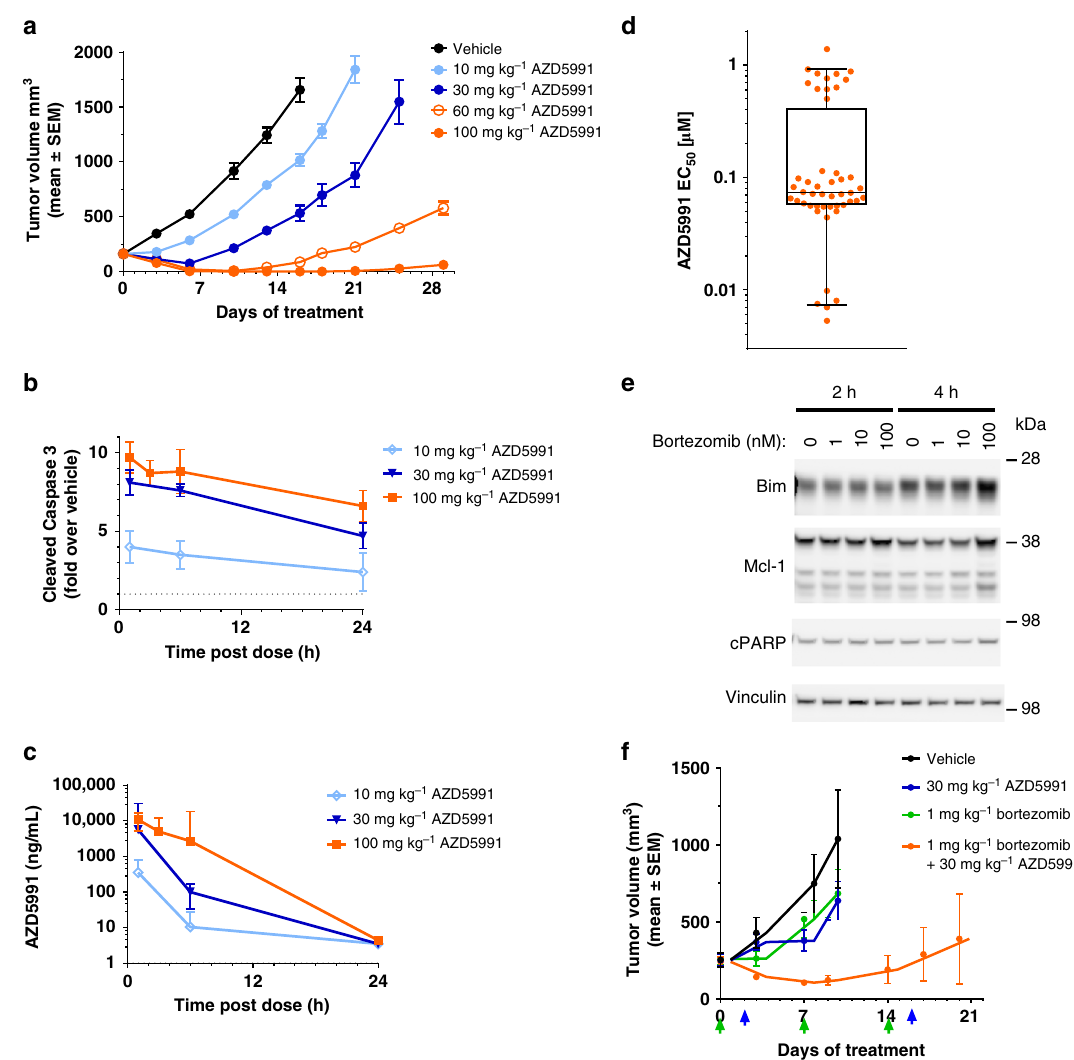
Fig. 6 AZD5991 exhibits potent anti-tumor ef fi cacy in MM models. a Subcutaneous tumor growth in the MOLP-8 tumor model treated with a single i.v. dose of AZD5991 10 – 100 mg kg − 1 . Tumor volumes are presented as mean ± SEM, seven mice were evaluated per group. b MOLP-8 tumor lysates prepared from mice dosed with a single i.v. dose of AZD5991 at 10, 30, or 100 mg kg − 1 were evaluated for expression of cleaved caspase-3 by MesoScale discovery assay. Mean± SD are shown. c In vivo plasma concentration of AZD5991 following a single i.v. dose of AZD5991 10 – 100 mg kg − 1 to mice with subcutaneous MOLP-8 tumors. AZD5991 plasma concentrations were assessed through the fi rst 24 h following compound administration. Concentrations of AZD5991 (ng mL -1 ) are plotted on a log 10 scale as mean ± SD ( n = 3). d Apoptosis in mononuclear cells isolated from bone marrow aspirate of MM patients ( n = 48) treated with increasing concentrations of AZD5991 for 24h and evaluated by Annexin V by fl ow. Each dot represents a unique patient sample. center line indicates the median, bounds of box denote 25% (lower) and 75% (upper) percentile, and whiskers encompass 5 – 95 percentile. e NCI- H929 cells were treated with bortezomib at the indicated concentrations, whole-cell lysates prepared after 2 or 4 h of treatment and protein expression evaluated by immunoblotting. f Subcutaneous tumor growth in the NCI-H929 tumor model treated with AZD5991 in combination with bortezomib. Both drugs were dosed intravenously. Arrows indicate day of dosing for AZD5991 (blue) and bortezomib (green). Tumor volumes are presented as mean ±